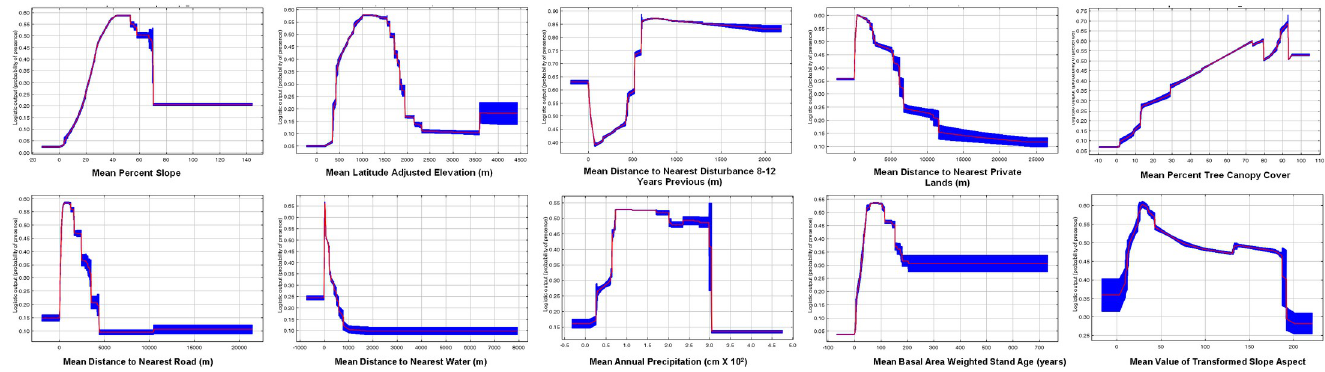
Fig 4. Univariate response curves for all predictor variables selected for the final model of trespass cannabis cultivation site likelihood in the modeling extent.